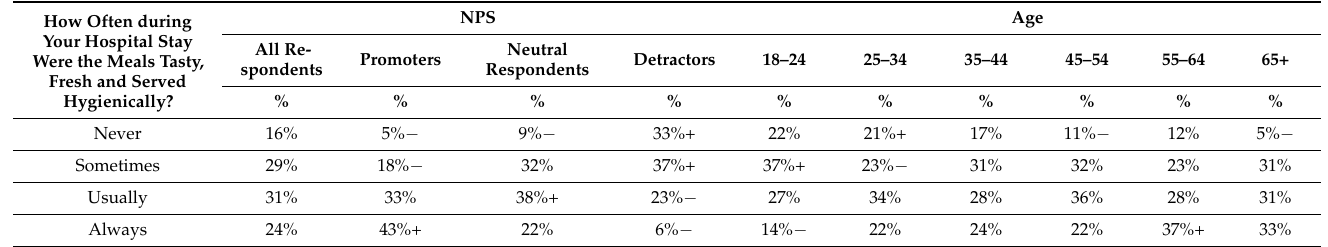
Table 3. Analysis of patients’ opinion on the quality and freshness of meals, and the hygiene of serving meals in hospital.